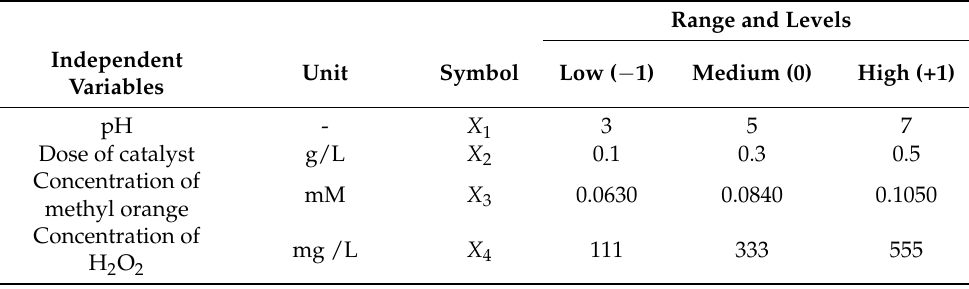
Table 2. Experimental design levels of chosen model parameters.